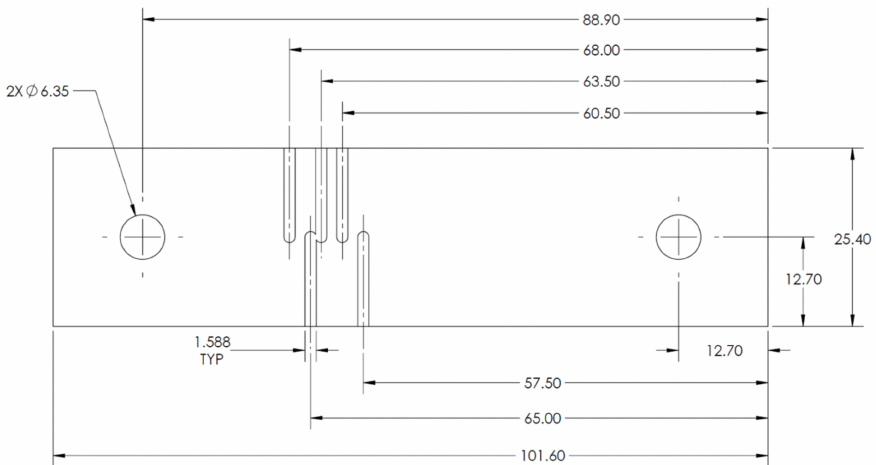
Figure 5. Thermocouple layout for CNC mill of AA 7075-T6 coupon.